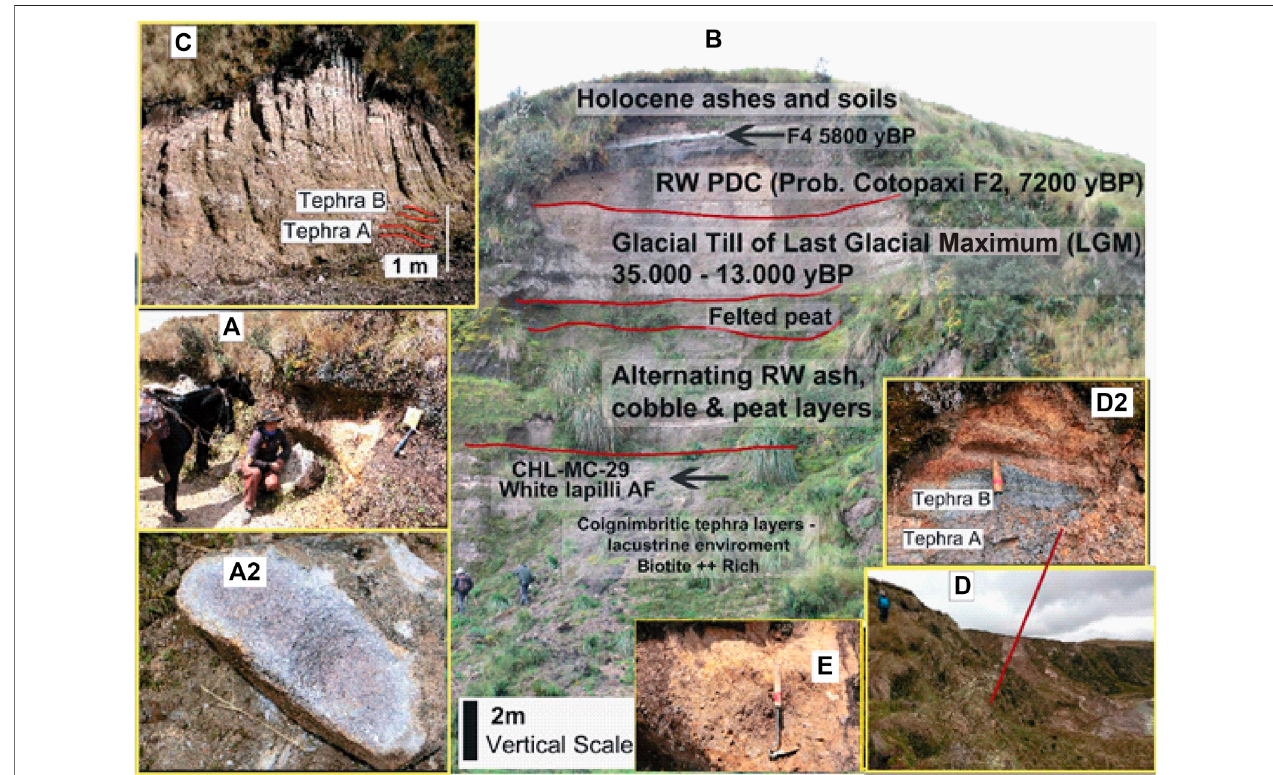
FIGURE9| Outcropswhichdisplay stratigraphiclayersrelated toBuenavistadomecomplex.Photo A isofacutinBuenavistastreamvalley,while A2 isacloseup of dacitic porphyritic, hornblende-bearing clast; (B) is section at Chictipamba, displaying the stratigraphic sequence, the tephra lapilli fallout layer CHL-MC-29, with a underlyingdateof43,620 ± 710 yearsBP,and 5 mofunderlying lacustrine/ fi ne-grainedlayers; (C) isoutcropat Locoyashunarivervalleywheretwofalloutlayers, (A,B) , predominantly of dacitic lithics, are hypothesized to be related to post dome collapse explosive activity of Buenavista dome complex; (D) is photo of 100 m deep cutonrightmarginoftheValleViciosoRiver.Atitsbaseisadatedpeatlayerof > 44kyBPandatintermediatelevelarethetwodaciticlithicfalloutlayers, (A,B) (photo D2 ), identical to the two layers logged at Locoyashuna cut (photo C ). Photo E is of an iron-stained matrix facies of breccia deposit outcropping at the Buenavista stream cut. Here lithic matrix is > 50%. An ashy co-ignimbritic layer caps the sequence.